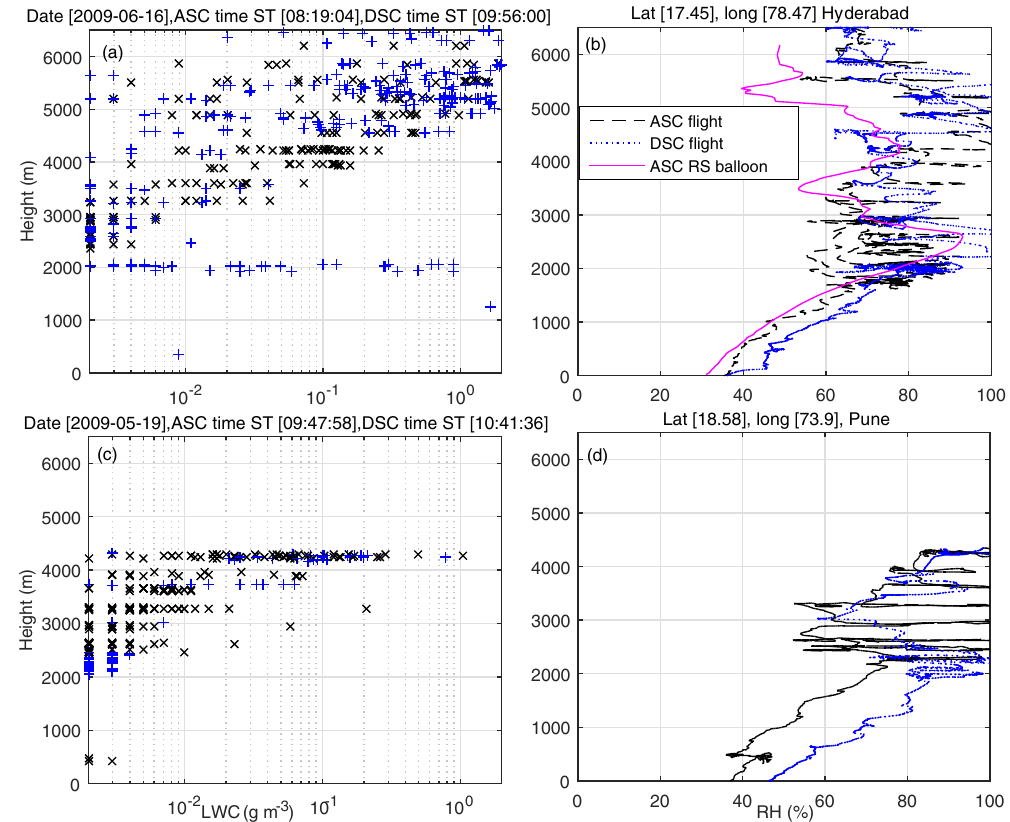
Figure 5. (a) Liquid water content (LWC) and (b) relative humidity (RH) observed over Hyderabad on 16 June 2009. Black and blue colours indicate ascending and descending flights, respectively. An ascending profile of RH using radiosonde observation is shown in magenta. Panels (c) and (d) are the same as (b) and (d) but observed over Pune during 19 May